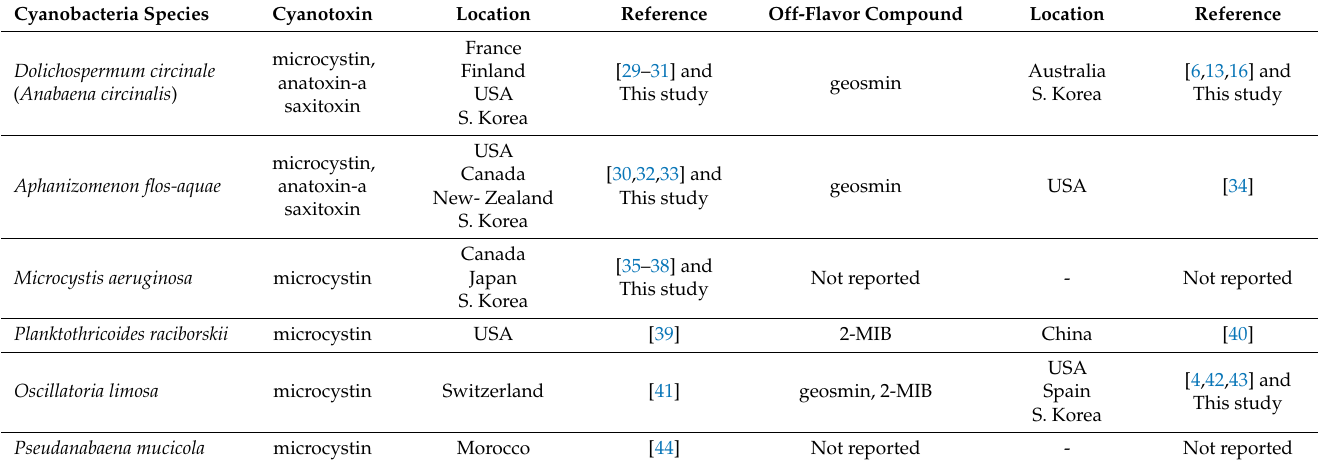
Table 2. Comparison of harmful cyanobacteria and the types harmful material produced in different geographic locations.